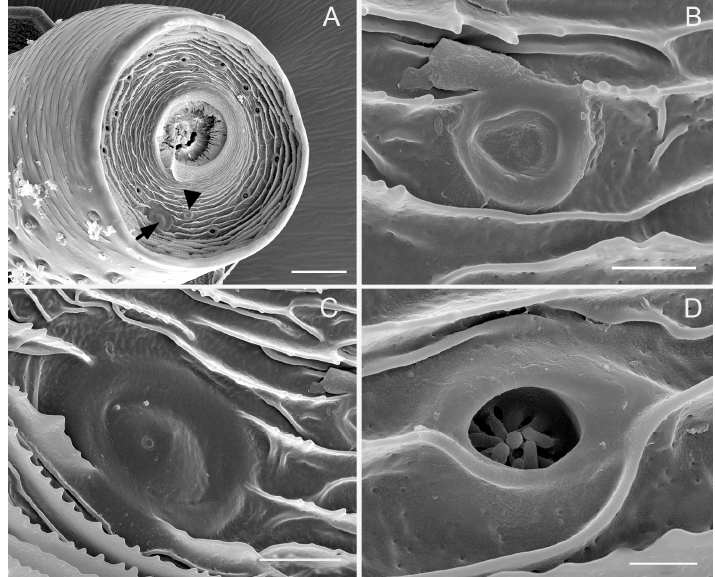
Figure 4. Antennal structures on the apical surface of the pedicel of adult Callitettix versicolor (Fabricius). ( A ) General view of the apical surface of the pedicel (black triangle indicates SCa2 and black arrow indicate SCa3), concentrically arranged cuticular ridges are visible; ( B ) High magnification image of sensilla campaniformia 1 (SCa1); ( C ) High magnification image of sensillum campaniformium 3 (SCa3); ( D ) High magnification image of sensillum coeloconicum (SCo1). Scale bars: A = 25 μm; B = 2.5 μm; C = 5 μm; D = 1.5 μm.